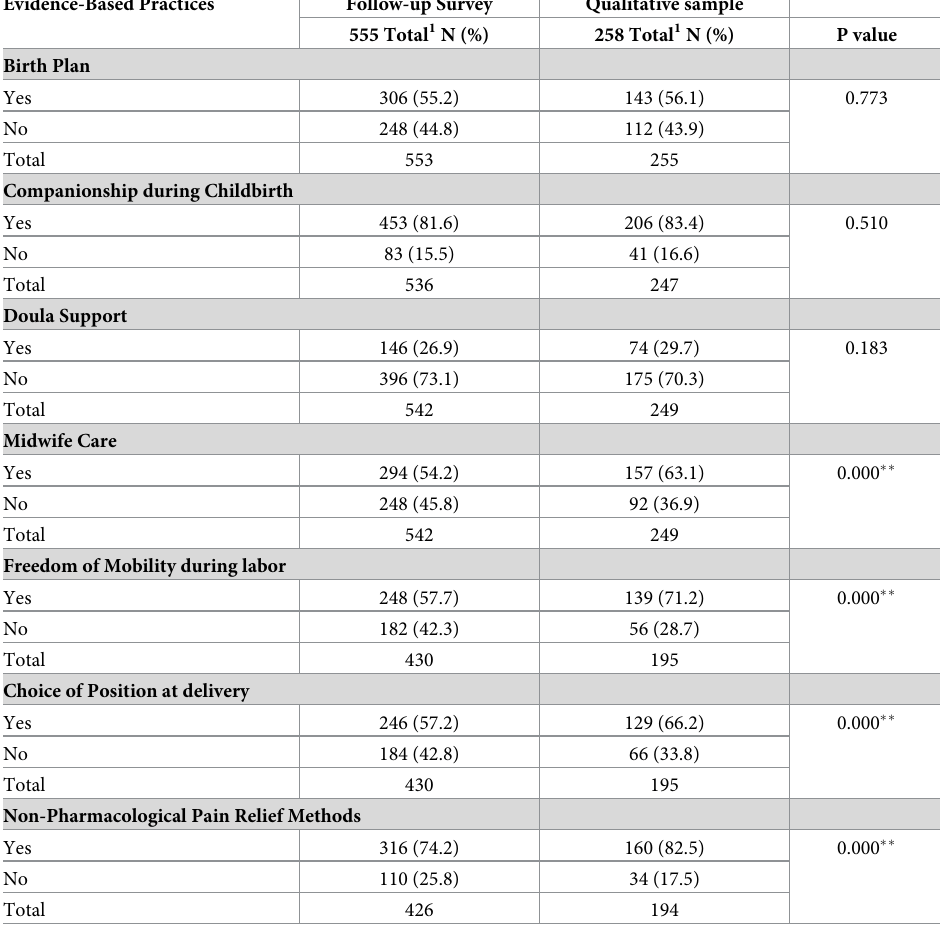
Table 2. Use of EBP among women who participated in the SoB intervention (follow-up and qualitative analysis). Brazil